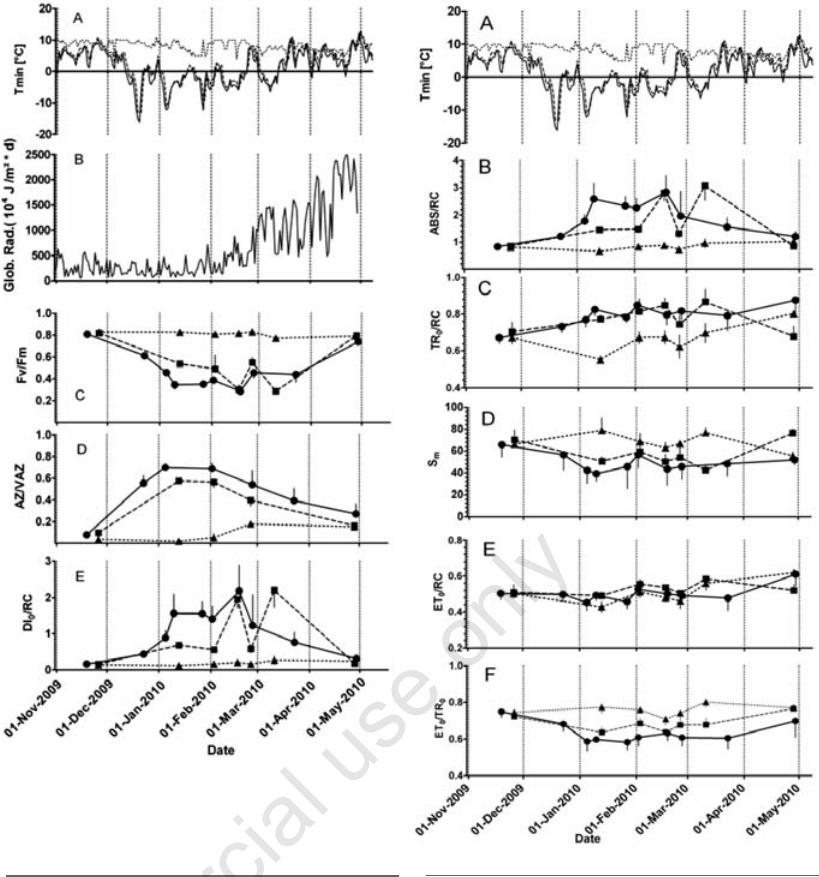
Figure 4. Semi-annual courses in winter of (4A) and of the OJIP-parameters T min /RC ABS/RC (4B), trapping efficiency TR 0 (4D), electron transport efficien- (4C), S m /RC /RC (4E), and electron transport cy ET 0 0 /TR (4F) in Q. ilex grow- probability ET 0 0 ing outdoors at RU ( ● ), FR ( ■ ) and FRFF ( ▲ ). Daily minimum temperatures (3A) given for RU (____), FR (------) and FRFF (…..). Means±SD, n=10 leaves per tree. Numbers of trees analysed were 6 in RU, 3 in FR and 4 in FRFF. ABS, absorption rate; , trapping rate; RC, reaction centre; TR 0 Frankfurt; FRFF, Frankfurt,